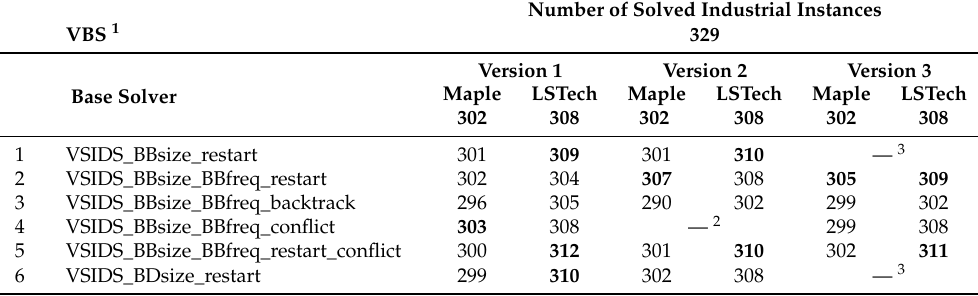
Table 3. Performance results of the CDCL SAT variants on industrial benchmark